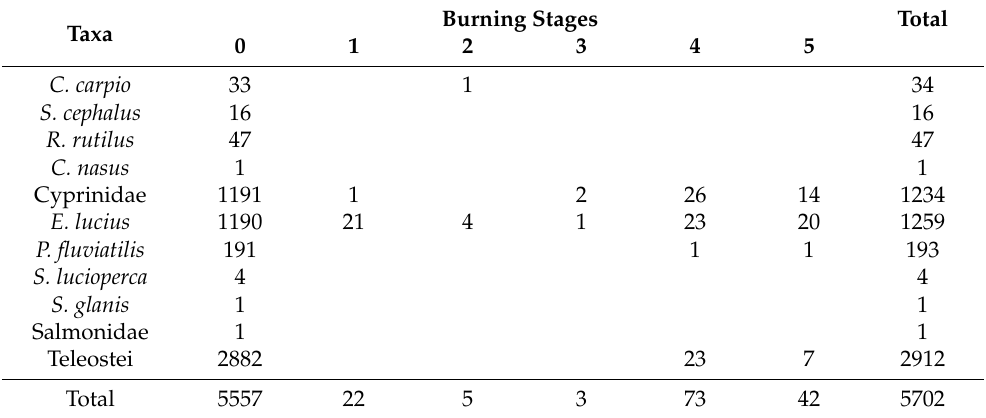
Table 6. The number of fish remains and burning stages observed on Borsodiv á nka fish remains (2020 campaign).